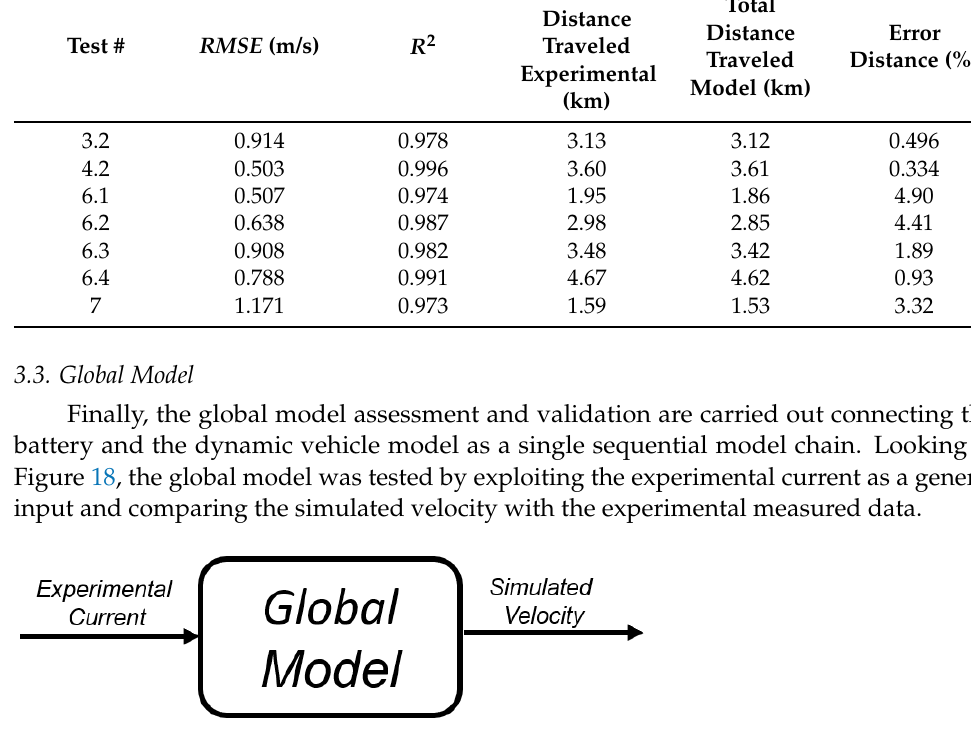
Figure 18. Global model I/O